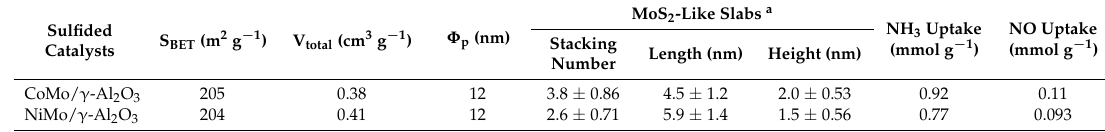
Table 1. Physicochemical properties of mesoporous sulfide catalysts.